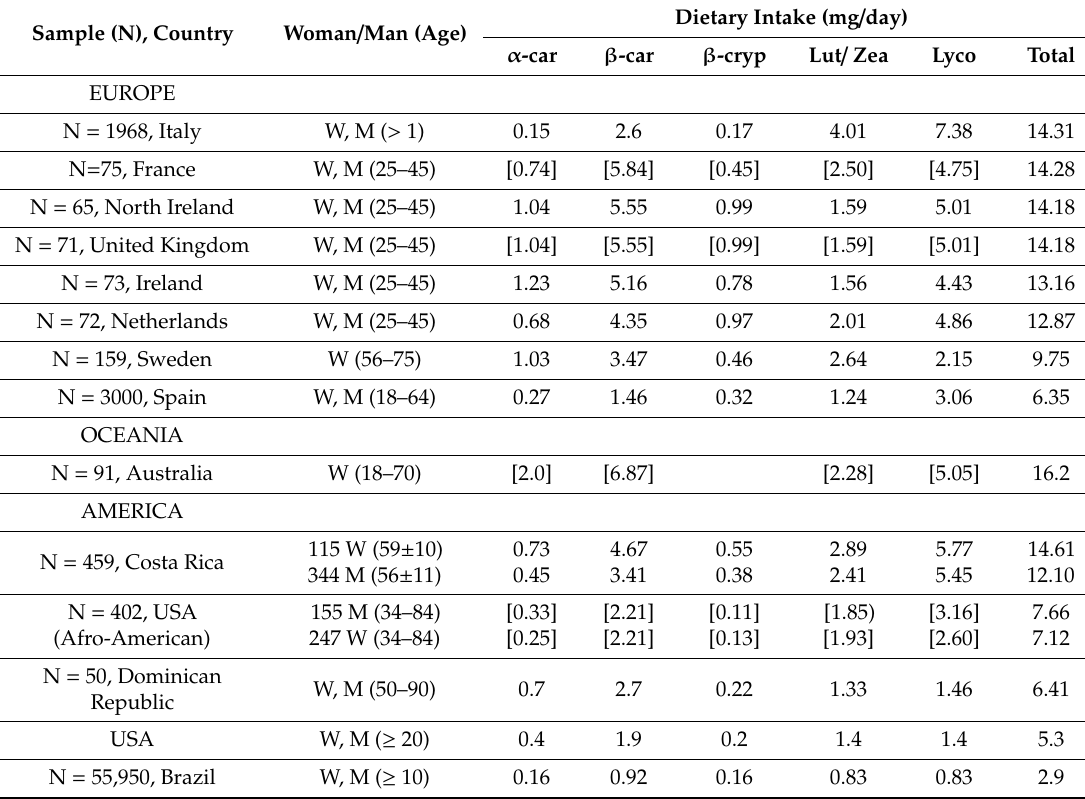
Table 2. Dietary consumption of carotenoids in di ff erent countries (data are reported as mean and [median]) [40,84,86].